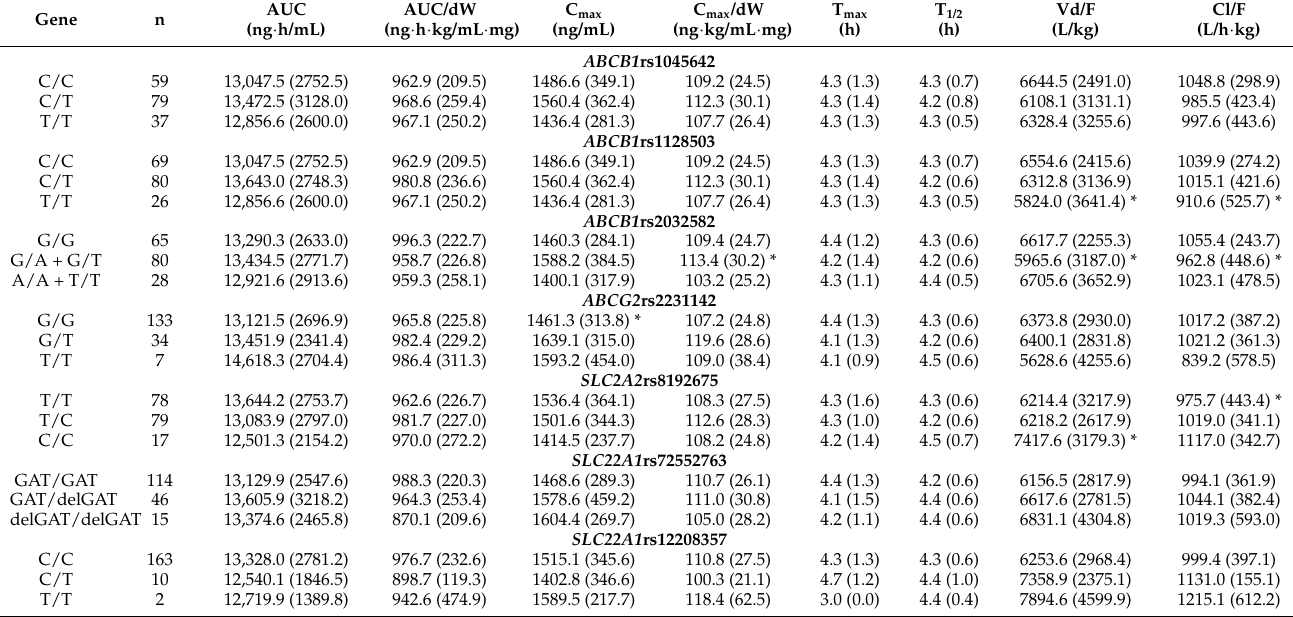
Table 3. Association between metformin pharmacokinetic parameters and polymorphisms in the studied